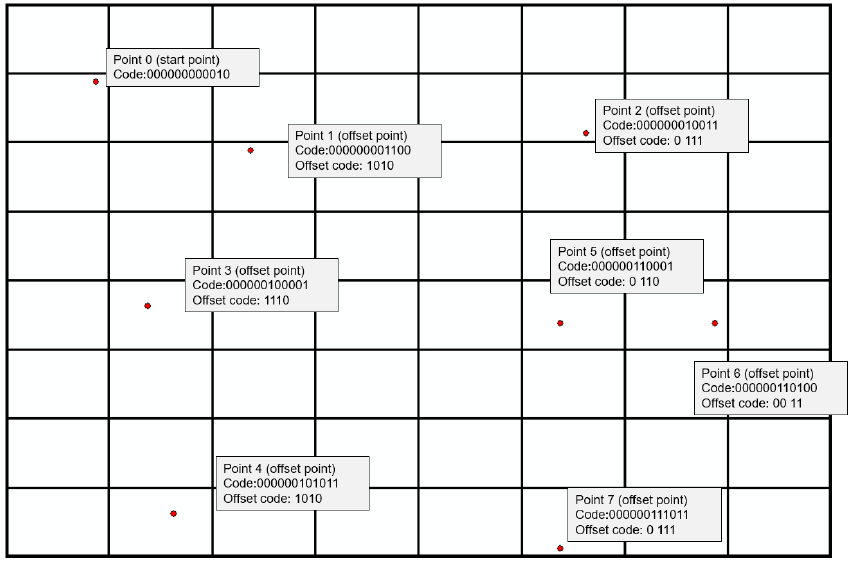
Figure 4. O ff set storage of point features diagram. Figure 4. Offset storage of point features diagram.